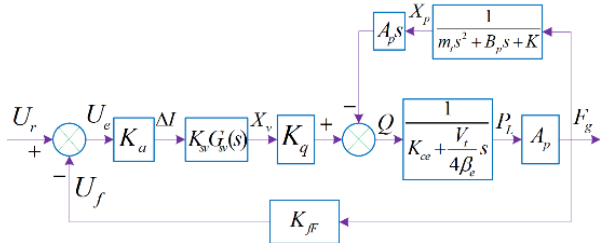
Figure 4. Hydraulic system block diagram with EHS control.